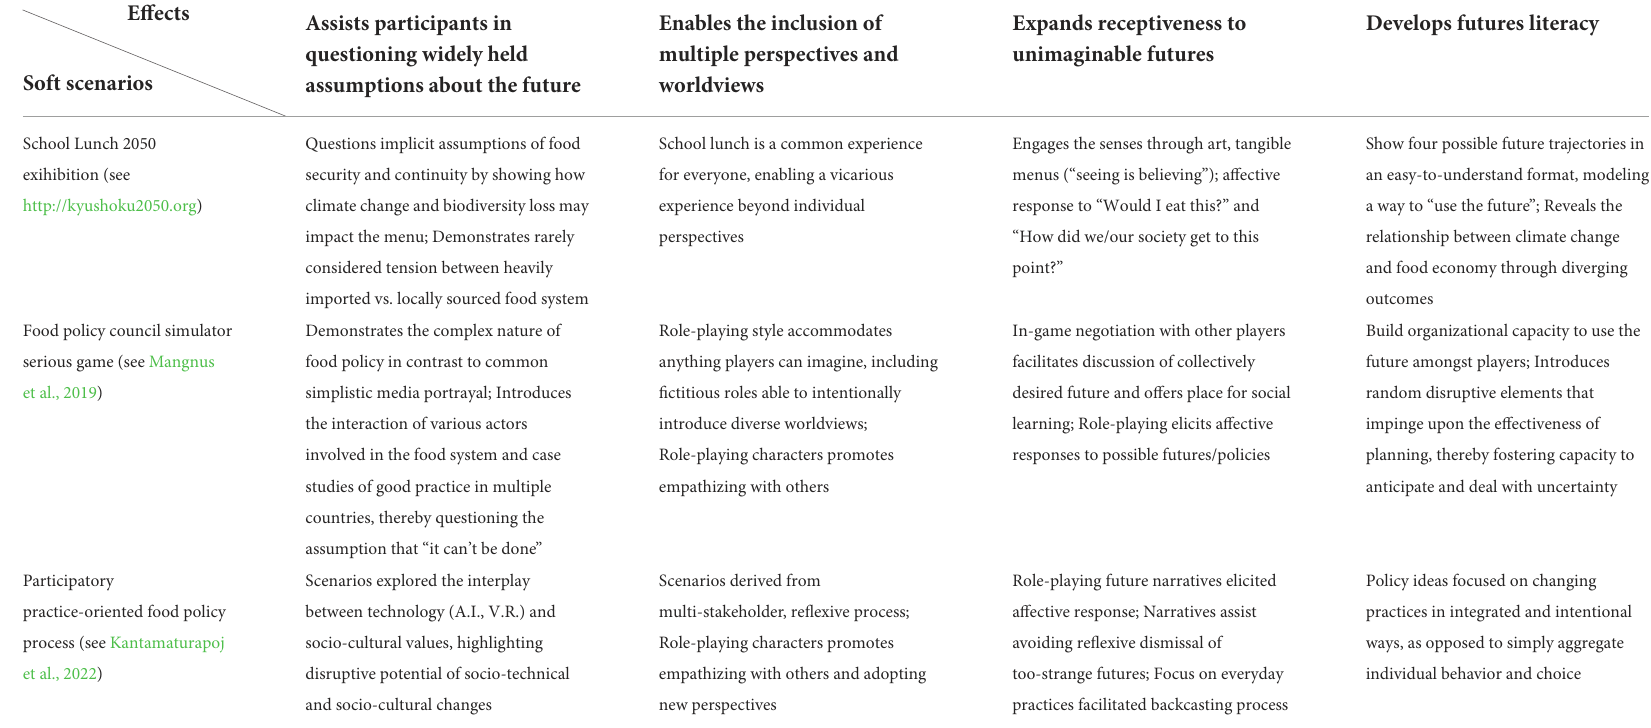
TABLE 2 Soft scenarios in action and their effects (adapted from McGreevy et al.,